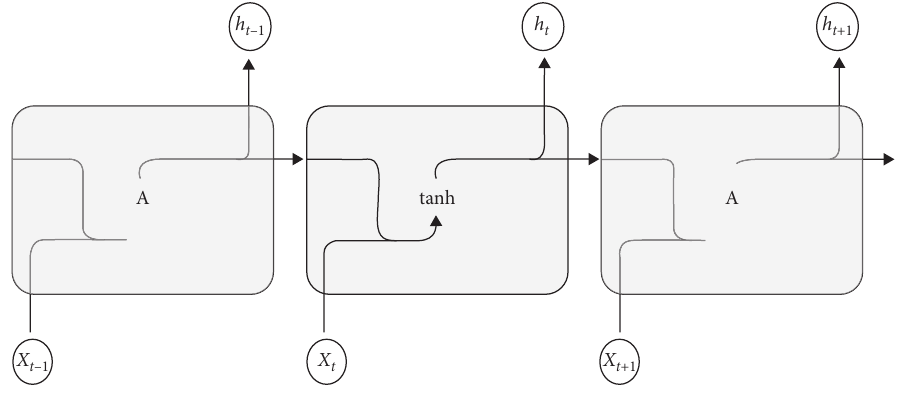
Figure 1: The simple structure of the RNN.